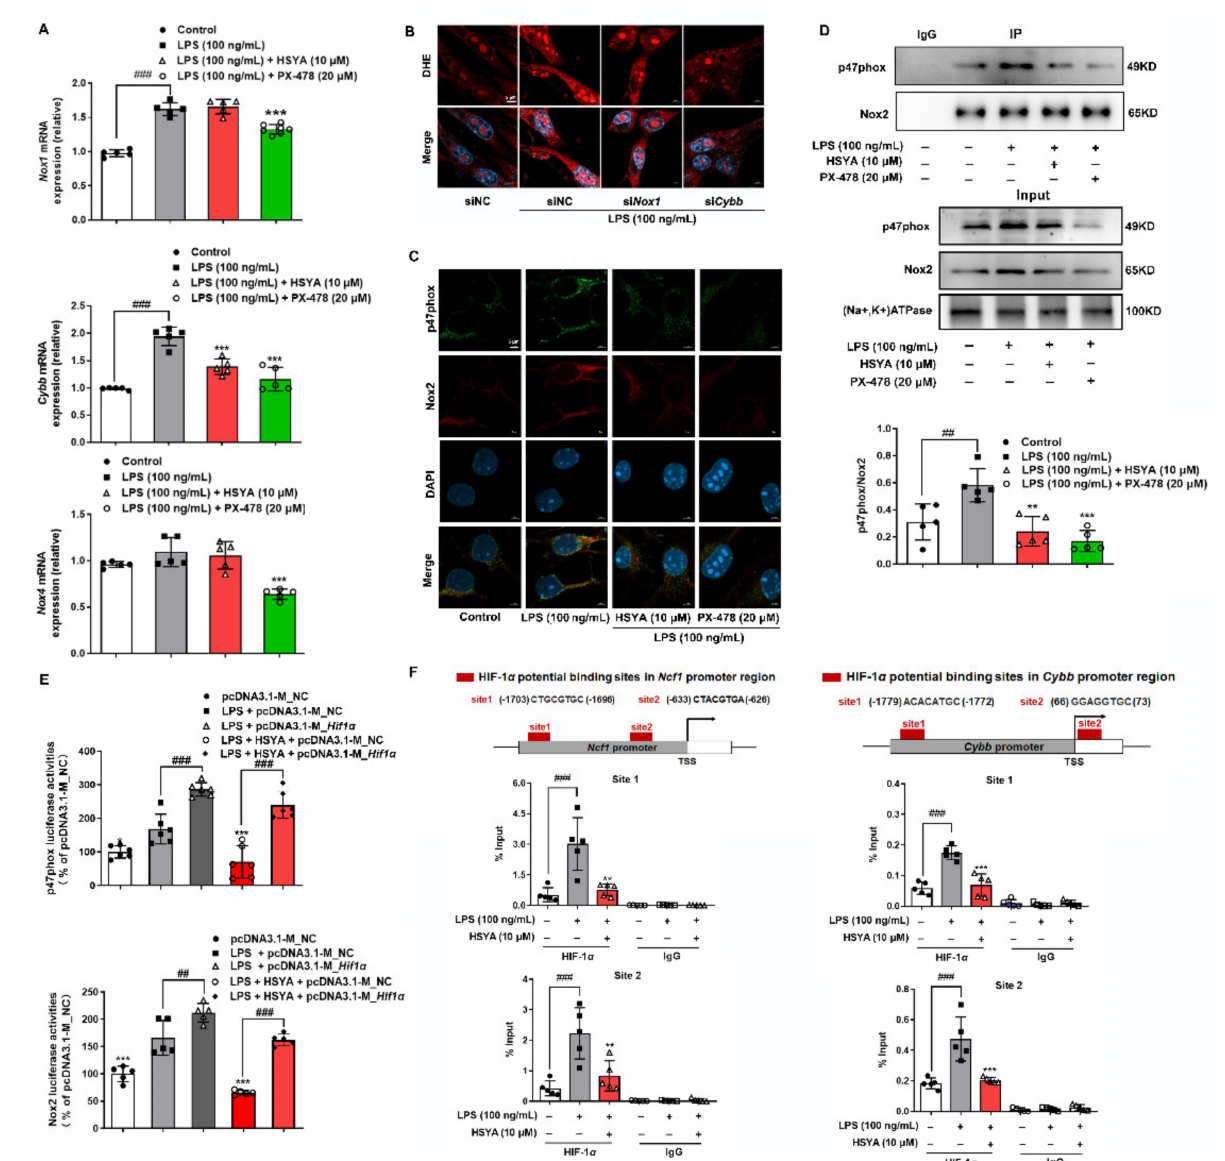
Figure 3. HIF-1 α transcriptionally regulated NOXs: ( A ) gene expression of Nox1 , Cybb , and Nox4 in LPS-induced bEnd.3 cells; ( B ) O 2 − production was viewed by dihydroethidium (DHE) staining in Nox1 or Cybb silencing cells (scale bar: 5 µ m); ( C ) immunofluorescence indicated the protein co-localization of p47phox (green) and Nox2 (red) in LPS-induced bEnd.3 cells (scale bar: 5 µ m); ( D ) the binding of p47phox to Nox2 was determined by immunoprecipitation; ( E ) bEnd.3 cells were transfected with vectors encoding HIF-1 α (pcDNA3.1-M_ Hif1 α ), and the luciferase report activity of p47phox and Nox2 was measured by luciferase reporter gene kits; ( F ) ChIP-qPCR analysis of HIF-1 α binding to the promoters of Ncf1 and Cybb in bEnd.3 cells in response to LPS insult. All data